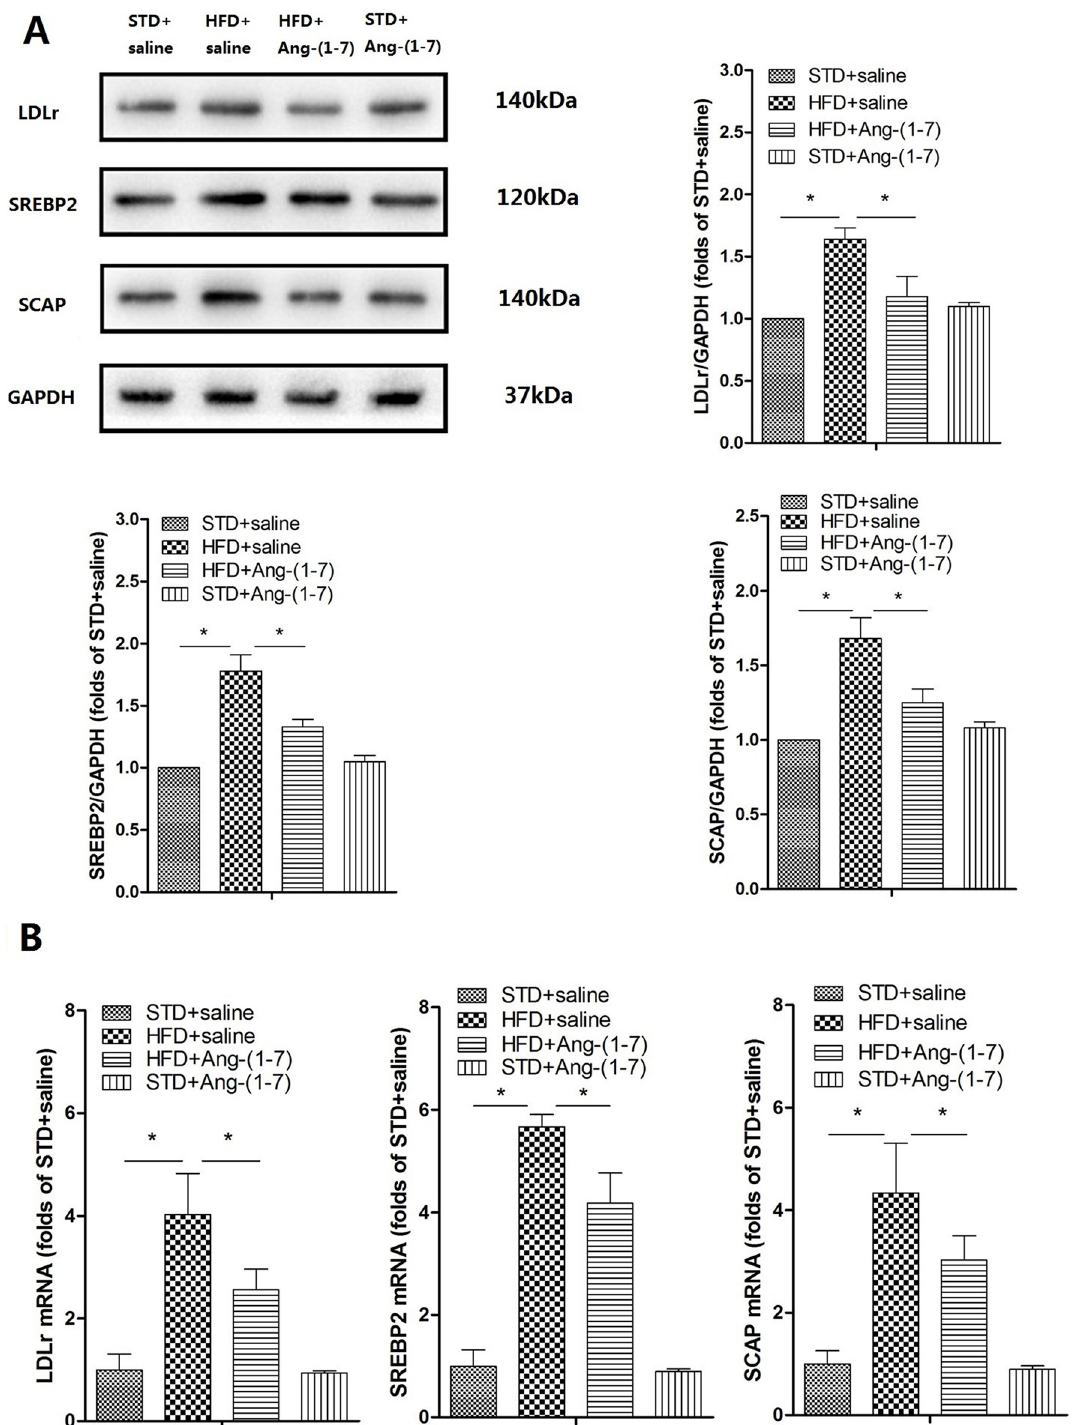
Fig 4. Ang-(1 – 7) inhibits HFD-induced LDLr, SREBP2 and SCAP expression in kidney. A: Representative immunoblots for LDLr, SREBP2 and SCAP. Representative quantitative analysis of LDLr, SREBP2 and SCAP. Values are expressed as means ± SD (n = 6). B: Real-time PCR was applied to measure mRNA levels. The GAPDH gene served as the internal control. Values are expressed as means ± SD (n = 6), * P < 0.05.